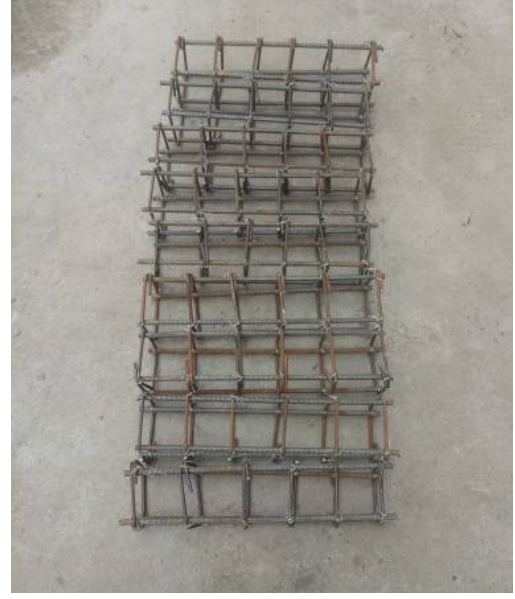
Figure 5. The reinforcement of the short column.